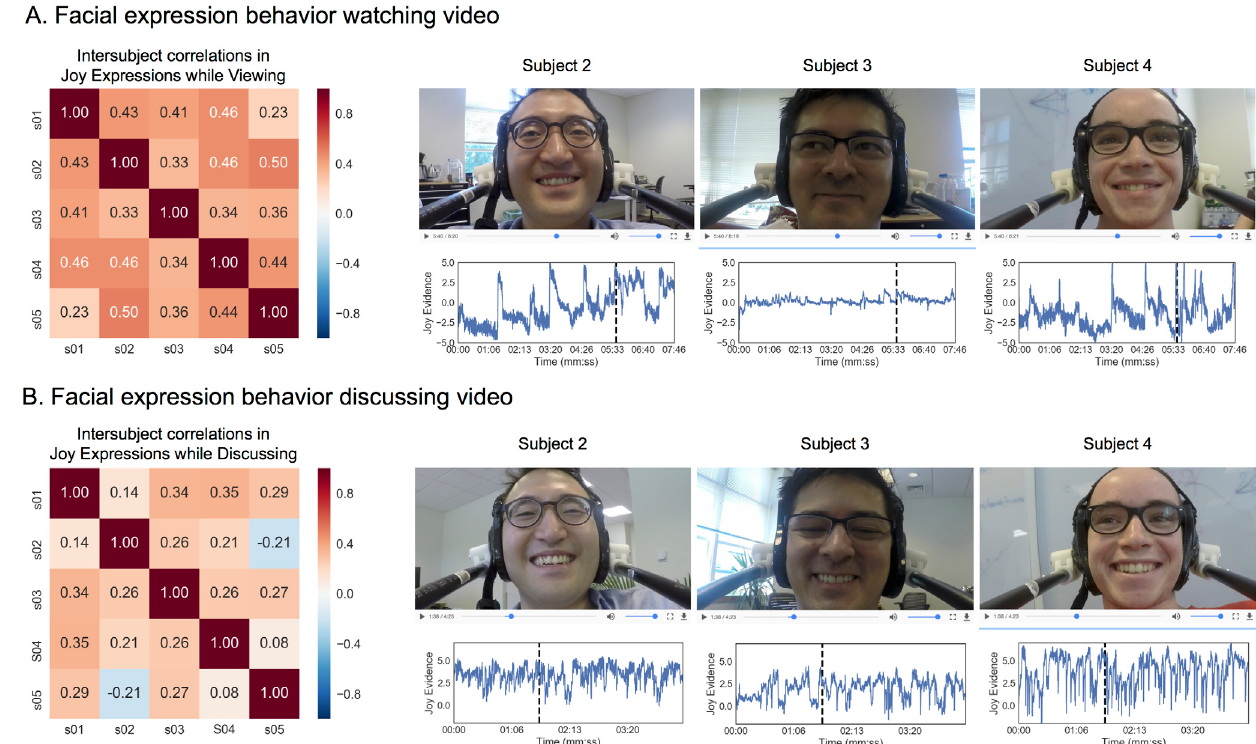
Figure 5. Facial expression behavior while watching and discussing video. ( A ) Pairwise intersubject similarity matrix for joy while watching the video is shown on the left panel. Three subject videos are shown on the right with corresponding joy evidence predictions. ( B ) Pairwise intersubject similarity matrix for joy while discussing the video is shown on the left